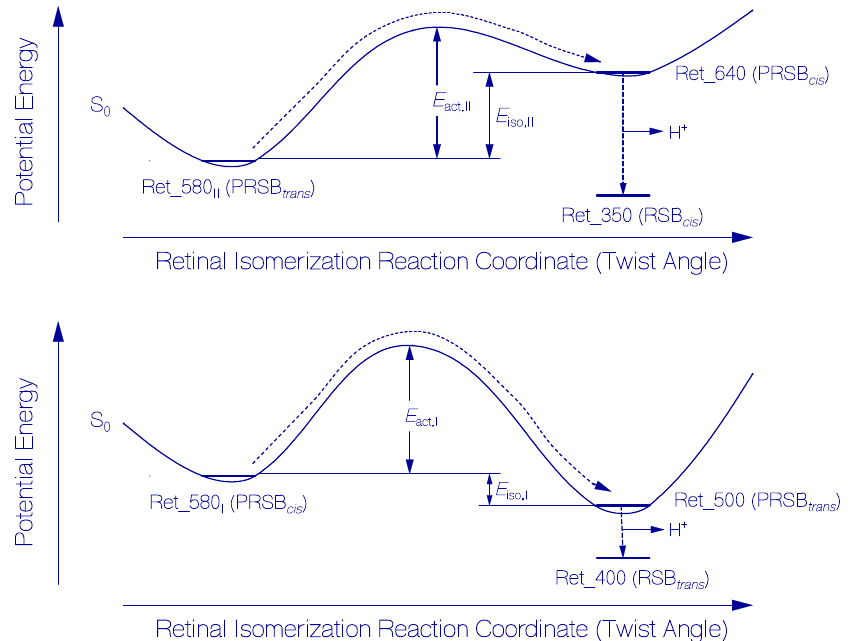
Figure 10. Schematic reaction coordinate diagrams for thermal activated S 0 ground-state protonated retinal Schi ff base isomerizations and apoprotein restructuring assisted irreversible deprotonations to retinalSchi ff baseisomers. Toppart: IsomerizationofRet_580 II